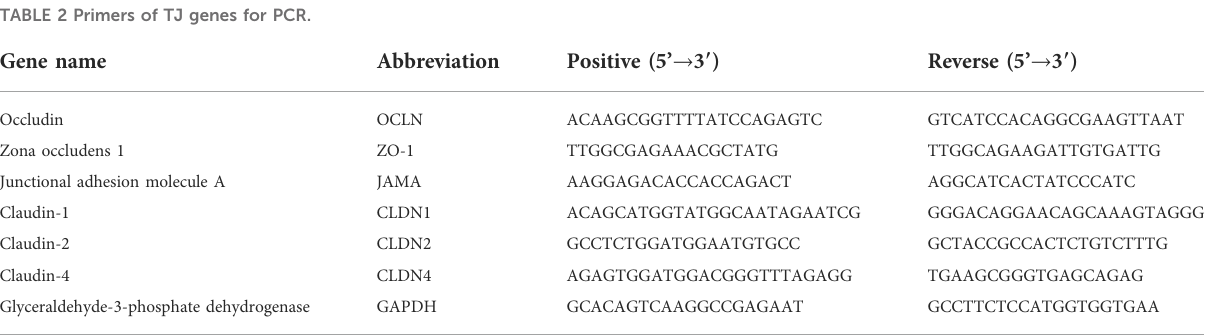
TABLE 2 Primers of TJ genes for